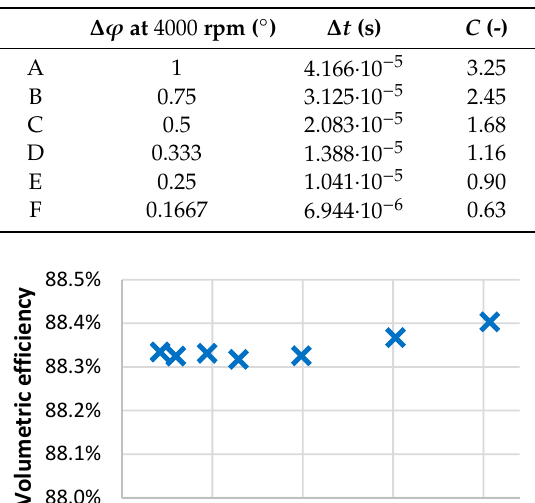
Table 3. Correlation between angular resolution and time step size at 4000 rpm and legend for Figure 13.